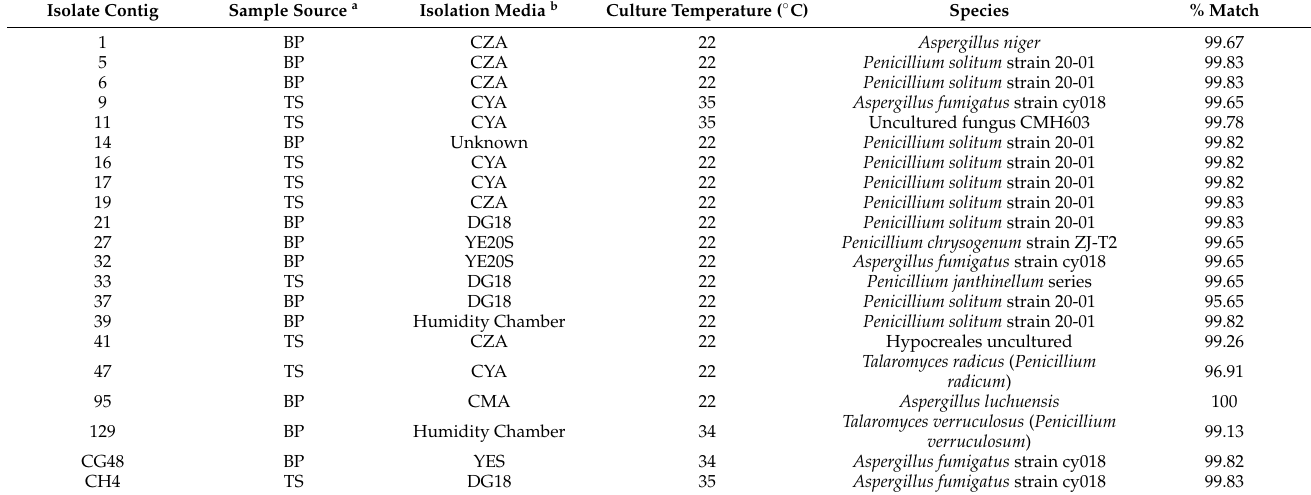
Table 2. Trichocomaceae isolates from bedding material collected at Farm C between October 2015 and May 2016. Species were identified by Sanger sequencing of the amplicon generated by NS7-F and ITS2-R primers and contigs assembled using CAP3 [27]. Nucleotide sequences were blasted in NCBI, all yielding E values of 0. Percentage nucleotide matching for the assembled contig sequence is